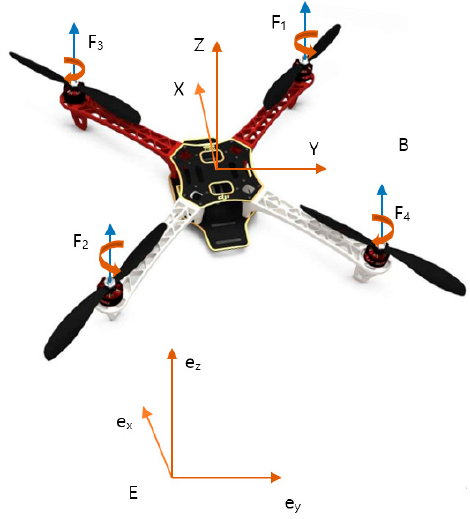
Figure 1. Quadcopter model.